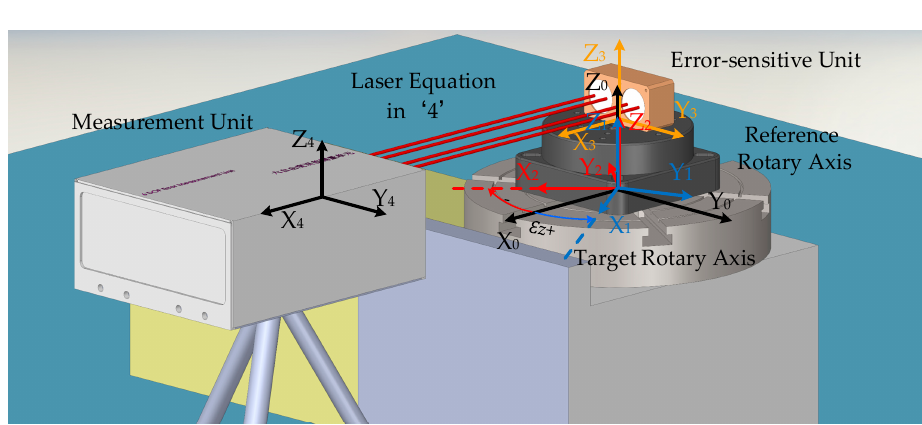
Figure 3. Schematic diagram of the experimental setup and coordinate systems. Table 1. Error variables and the naming rules.